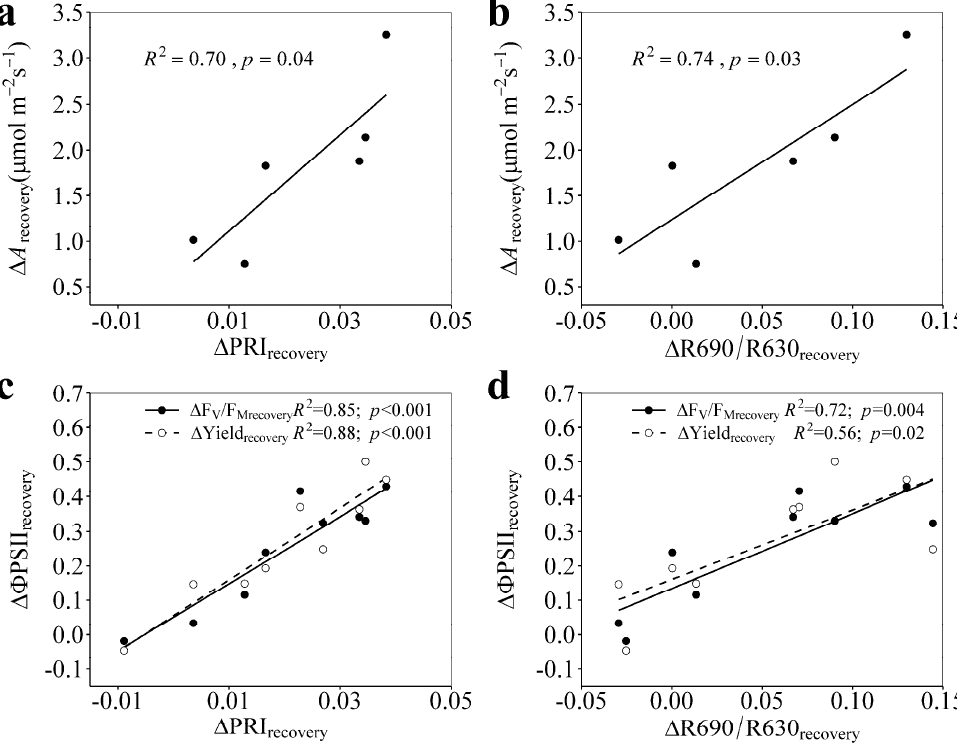
Figure 5. Relationships of differential A ( Δ A recovery ) with Δ PRI recovery ( a ) and Δ R690/R630 recovery ( b ), and photochemical efficiency of PSII ( ΔΦ PSII ) (F V /F M and Yield) with Δ PRI recovery ( c ) and Δ R690/R630 recovery ( d ) for Quercus ilex . All the differential values are from Figure 4.